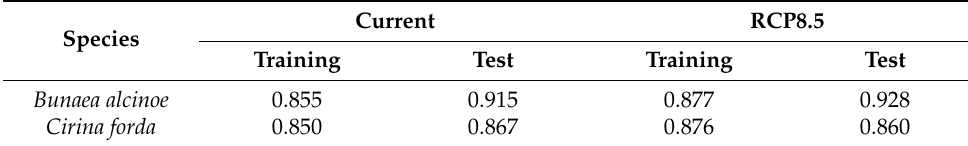
Table 5. Area under curve values for training and test data.